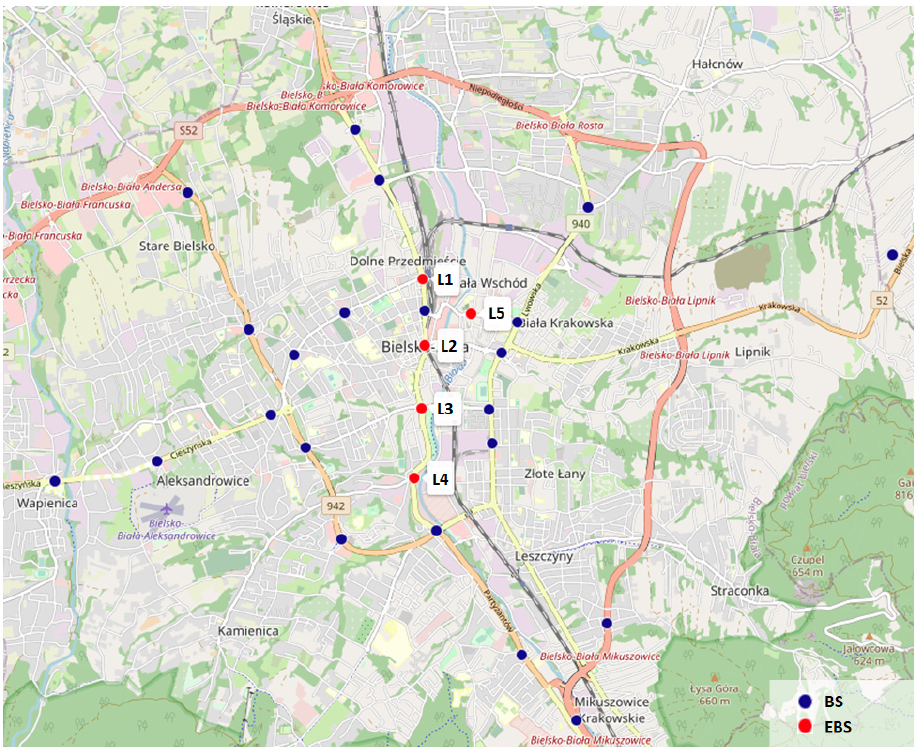
Figure 1. Locations of the OnDynamic system sensors on the road network in Bielsko-Biała (BS—base station, EBS—extended base station allowing simultaneous recording of concentrations of CO and PM). Map source: OpenStreetMap.